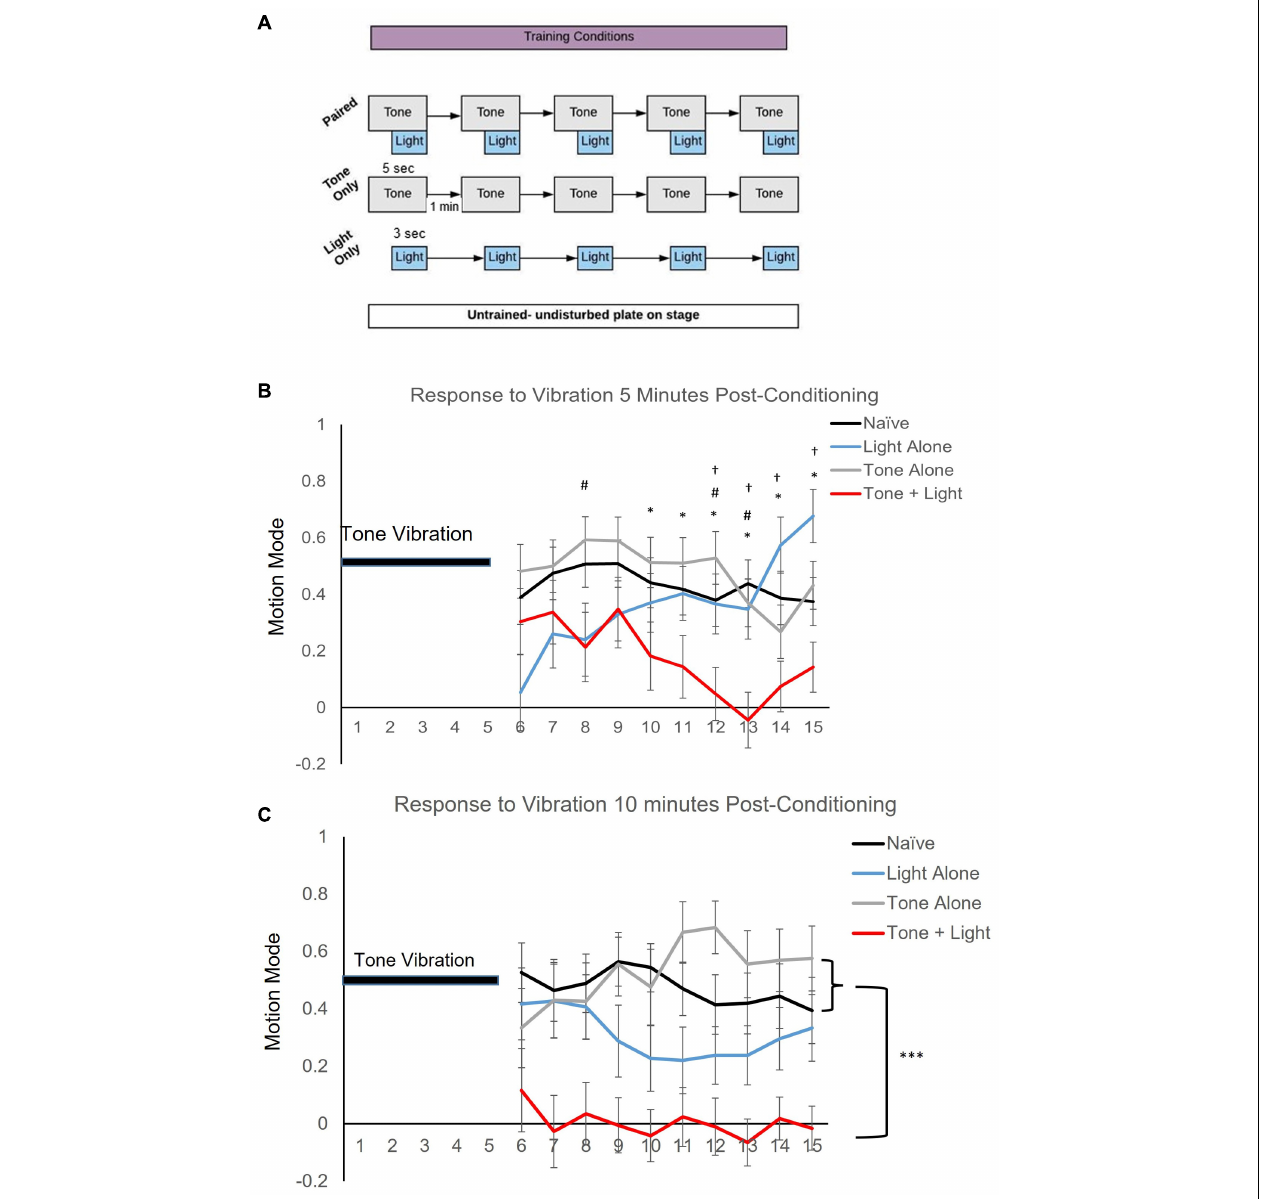
FIGURE 2 | Training condition affects locomotor direction of worms following a single tone stimulus. (A) Training protocol showing Naïve (untrained), Tone Alone, Light Alone and Paired conditioning. Stimulus pairing consisted of five presentations of a 5-s tone vibration stimulus delivered with a 3-s blue light stimulus at a 2-s delayed onset. Testing consisted of a single 5-s tone stimulus. (B) Mean motion mode ( ± SEM) (indicates average vector of movement direction whereby + values signify forward and − values signify backward locomotion direction) captured for the 10-s period following the 5-s test tone at 5 min after conditioning. Post-hoc analyses indicate: ∗ p < 0.05 between Naïve ( n = 46) and Paired ( n = 29); # p < 0.05 between Tone Alone and Paired ( n = 25); † p < 0.05 between Light Alone ( n = 30) and Paired training conditions. (C) Mean motion mode ( ± SEM) captured for a 10-s period following a 5-s test tone at 10 min after conditioning. Post-hoc analyses indicate: ∗∗∗ p < 0.001 of main effects.